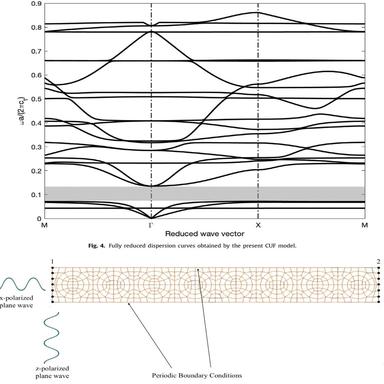
Transmission curves analysis set up.